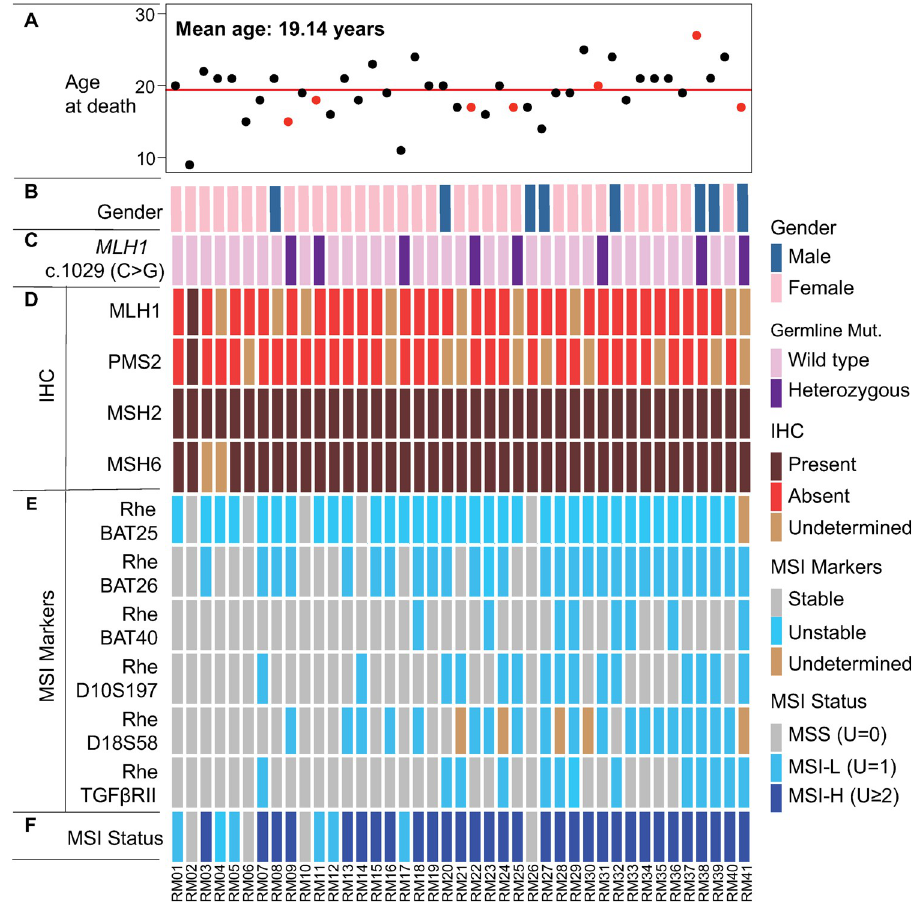
Fig 2. Clinical, pathological, and molecular characteristics of the Rhesus cohort. (A) Animal ages at the time of diagnosis of CRC and subsequent euthanasia. The average age at death for the rhesus CRC cohort was 19.14 years. Red dots indicate the age of animals with MLH1 germline mutation; (B) Gender of rhesus cohort. The majority of animals in this cohort were female; (C) Lynch syndrome MLH1 germline mutation status. A total of eight (20%) carried a heterozygous MLH1 nonsense mutation (c.1029, C > G); (D) IHC assessment of rhesus CRC. The majority of rhesus tumor samples displayed loss of MLH1 and PMS2; (E) MSI testing of rhesus tumors. Newly designed MSI testing panel for rhesus CRC included six markers (RheBAT25, RheBAT26, RheBAT40, RheD10S197, RheD18S58, and RheTGF β RII) that were orthologs of commonly tested MSI loci in human tumors (BAT25, BAT26, BAT40, D10S197, D18S58, and TGF β RII). Overall, RheBAT25, RheBAT26, and RheD18S58 MSI markers were the most mutated MSI markers in rhesus CRC; (F) Summary of MSI status of rhesus tumors. Rhesus CRC were predom-inantly MSI-H (75%), and only six tumors (15%) were MSI-L, and four (10%) MSS. Using the newly designed rhesus MSI panel, we performed MSI testing in all tumors from the KCCMR cohort using matched normal samples as genomic reference (n = 41). c-kitRhe- BAT25, RheBAT26, and RheD18S58 markers were the most sensitive ( Fig 2E ). We validated the calls made in RheBAT26 and RheD18S58 using an alternative technique based on fragment analysis ( S5 Fig ). We classified rhesus tumors into the three classical categories (i.e. MSI-H, MSI-L, and MSS) by counting the number of unstable markers in each tumor, thus following the classical NCI recommendations [14]. Thirty-one samples were MSI-H (76%), six were MSI-L (15%), and four were MSS (10%, Fig 2F ). Two rhesus LS animals (RM11 and RM17) displayed an MSI-L phenotype and six rhesus LS animals (RM09, RM22, RM25, RM31, RM38 and RM41) presented an MSI-H phenotype ( Fig 2C and 2F ).